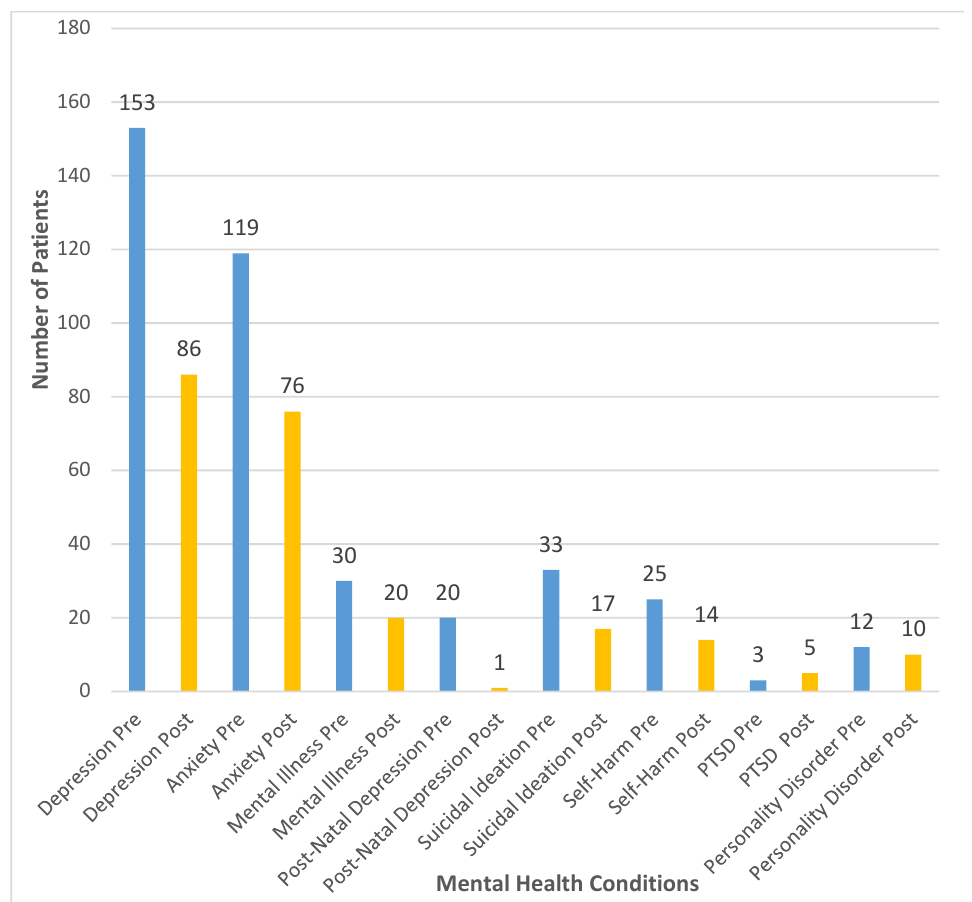
Figure 8. Mental health conditions existing pre- and post-IRIS intervention and mental health captured during qualitative phase. When taken together, the insights from both strands of this mixed- methods study point to a potential decline in overall health conditions after IRIS support is pro- vided. Although there are limits to the inferences that can be drawn from a mixed methods perspec- tive, it does not however detract from the importance of the quantitative results in isolation and